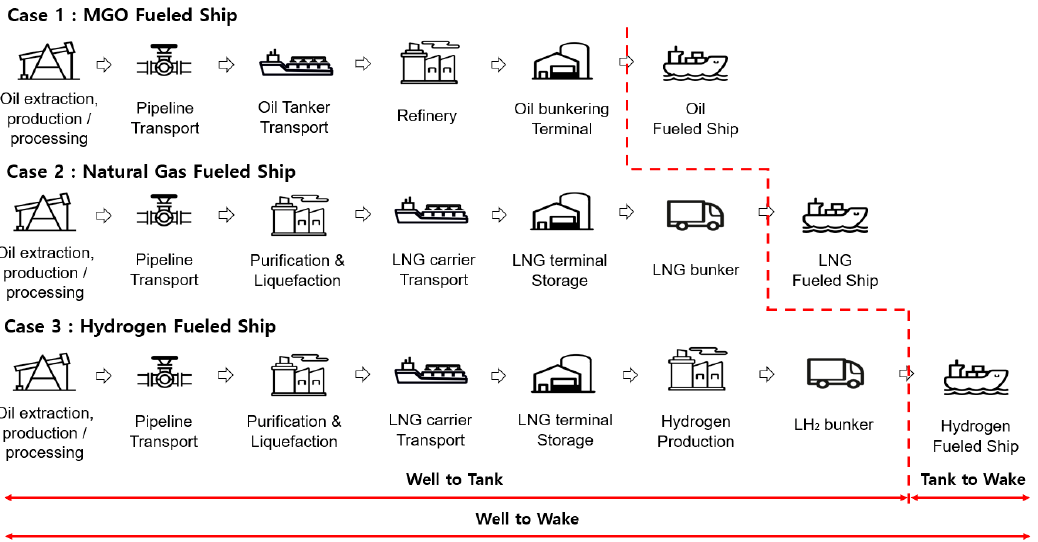
Figure 2. Life cycle of marine gas oil (MGO), natural gas, and hydrogen.